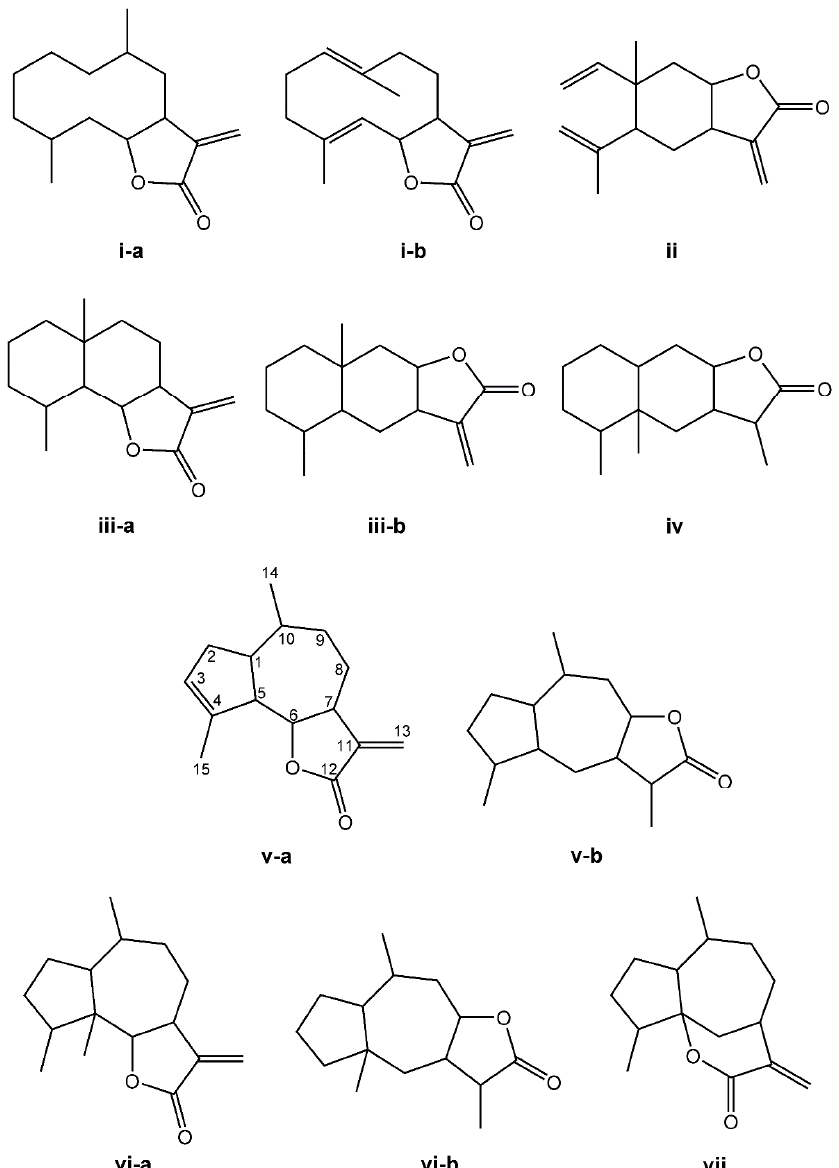
Figure 1. Structures of the main sesquiterpene lactone-type skeletons: germacranolide isomers ( i-a , i-b ); elemanolide ( ii ); eudesmanolide isomers ( iii-a , iii-b ); eremophilanolide ( iv ); guaianolide isomers ( v-a , v-b ); pseudoguaianolide isomers ( vi-a , vi-b ); and hypocretenolide ( vii ).